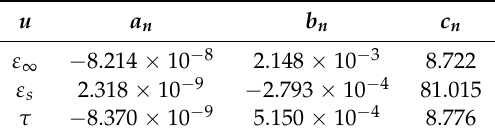
Table 2. Polynomial coefficients fitted to the Debye parameters [33]. Reproduced with permission from Turgul V., Kale I., Sensors and Actuators A: Physical, Elsevier,